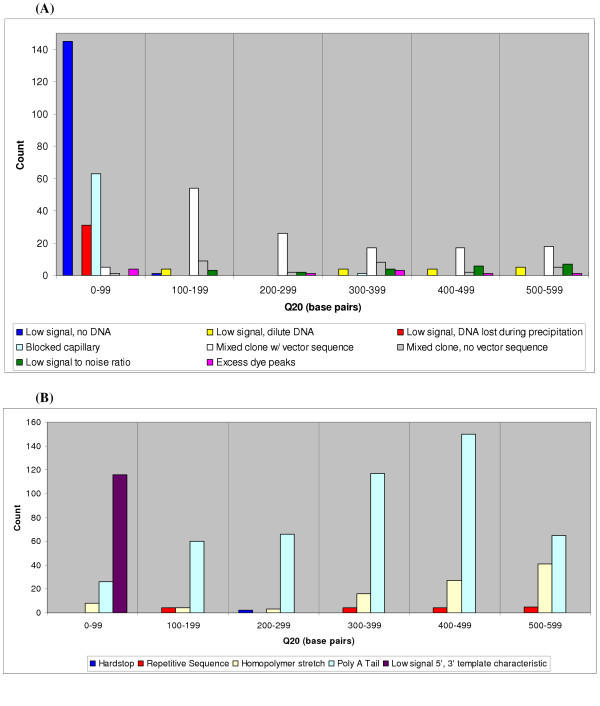
Process failure mode distribution (A) Process-related failure mode distribution. Most of the process-related failed reads have a Q20 < 100 with the primary mode of failure being "Low signal, no DNA," or no template DNA in the sequencing reaction (confirmed by agarose gel electrophoresis). (B) Template-related failure mode distribution. Most of the template-related failed reads are a result of "Poly A Tail," or 3' poly A stretch that leads to slippage in sequence data. Reads with a "Low signal 5', 3' template characteristic" failure mode contribute to the largest proportion of data with read lengths Q20 < 100.